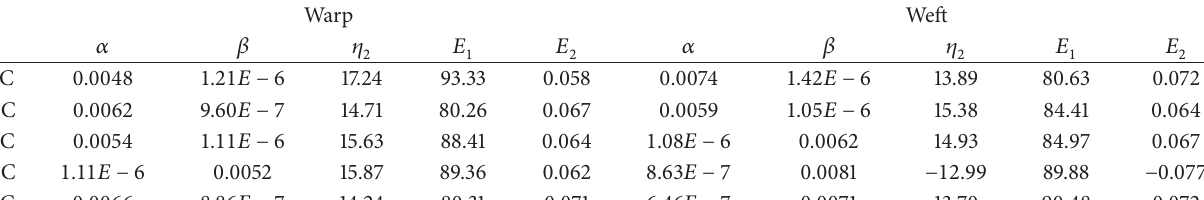
Table 5: Parameter results of the Burgers model.